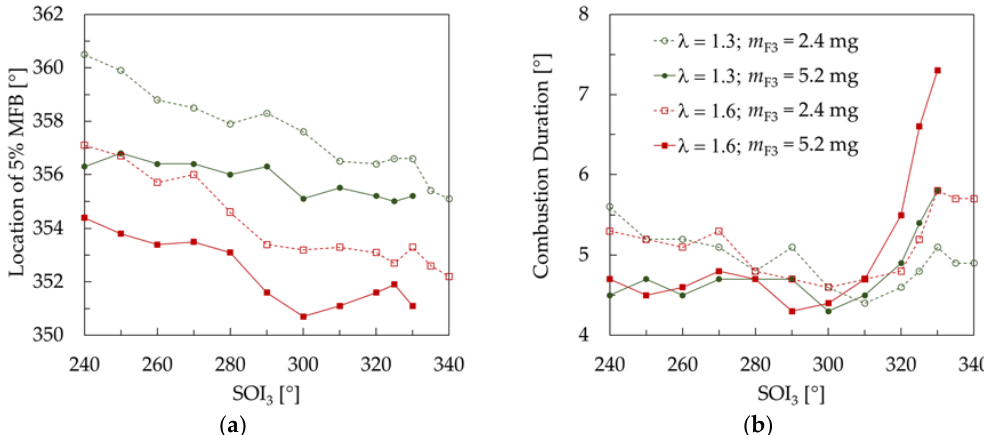
Figure 6. Location of 5% mass fraction burned (MFB) ( a ) and combustion duration (5–95% MFB) ( b ) versus SOI 3 timing for all investigated conditions.